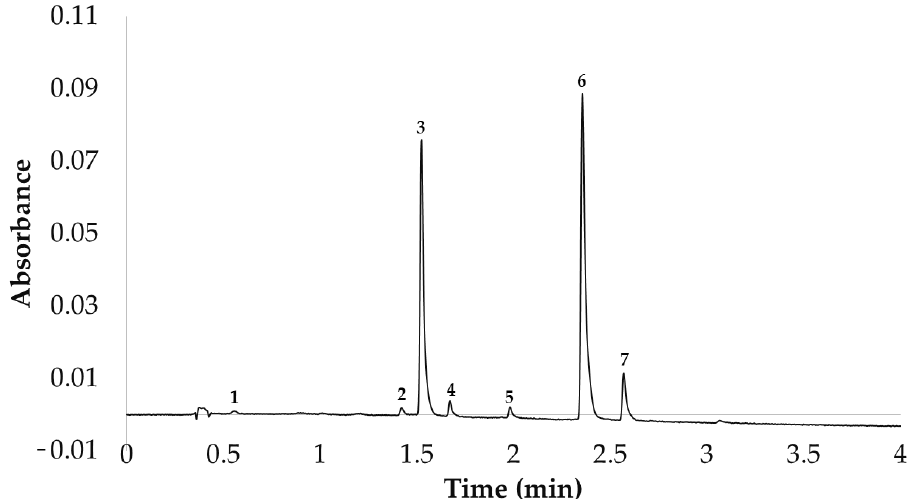
Figure 1. Representative red onion chromatogram at 360 nm. ( 1 ) Quercetin 3,7,4 ′‐ O ‐ triglucoside; ( 2 ) quercetin 7,4 ′‐ O ‐ diglucoside; ( 3 ) quercetin 3,4 ′‐ O ‐ diglucoside; ( 4 ) isorhamnetin 3,4 ′‐ O ‐ diglucoside; ( 5 ) quercetin 3 ‐ O ‐ glucoside; ( 6 ) quercetin 4 ′‐ O ‐ glucoside; ( 7 ) isorhamnetin 4 ′‐ O ‐ glucoside.